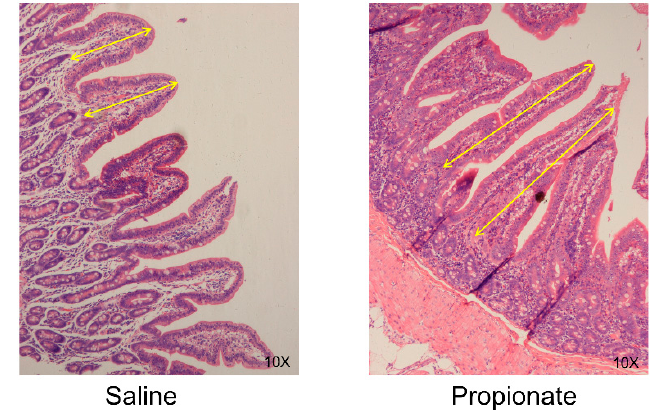
Figure 1. Histological evaluation of jejunal tissues from pig exposure to saline and propionate by hematoxylin and eosin (H&E)-Staining. The yellow arrows denote villi length used for measurement. Table 4. Effects of the cecal infusion of sodium propionate on the intestinal morphology.